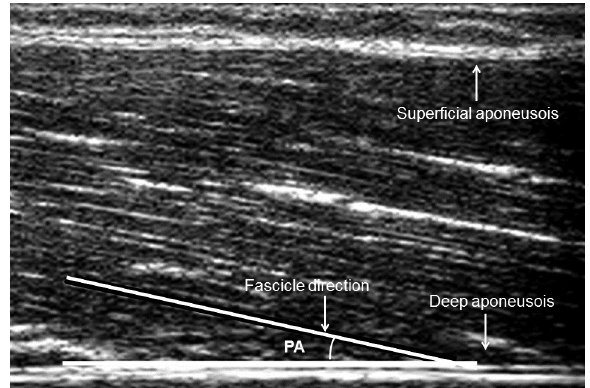
Figure 1 - Illustration of the muscular ultrasonography im- age, where the directions of the fascicles and of the apo- neurosis are shown. The highlighted white lines, which cor- respond to straight lines that were drawn to measure the PA, arrows and texts, were edited on a photo taken from the screen of the ultrasound